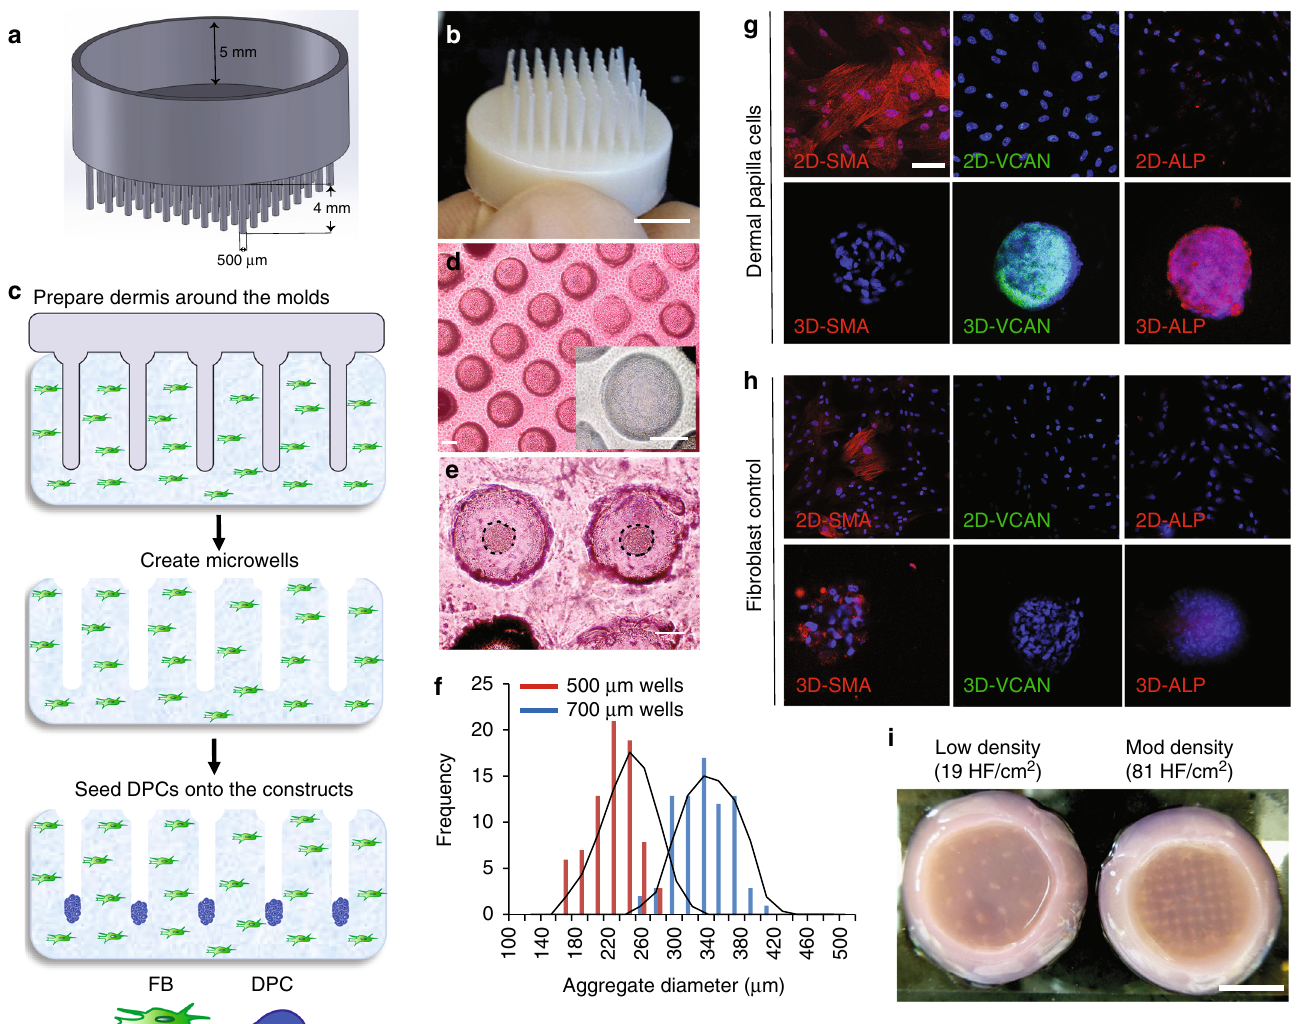
Fig. 1 Patterning of collagen type-1 gel using 3D-printed molds allows for physiological arrangement of cells in the hair follicle. Hair follicle molds were designed ( a ) and 3D-printed ( b ) to have HF-like extensions and a 5-mm-deep cavity that allows the molds to fl oat on collagen gel. c The collagen gel containing dermal fi broblasts was allowed to solidify around the HF-like extensions to create an array of microwells in which the DPCs formed spontaneous aggregates. d Top view of HSCs containing DPCs which settled down into the microwells (lower panel: higher magni fi cation of the microwells). e DPCs formed spontaneous aggregates at the center of the microwells (dashed line circles the aggregates). f The size of DPC aggregates, as calculated from images, was correlated with the diameter of the microwells (500 µ m wells in red and 700 µ m wells in blue) ( n = 9; three technical and three biological replicates). Expression of SMA and VCAN and the activity of ALP in 2D cultures of DPCs and in DPCs aggregates formed in the microwells ( g ) was compared to 2D cultures of FBs and FB aggregates in the microwells ( h ). i Top view of the 3D-reconstructed dermis at two different hair follicle densities of 19 HF per cm 2 and 81 HF per cm 2 . Scale bars for ( d ) and ( e − h ) are 100 µ m and 5 mm for ( b ) and ( i